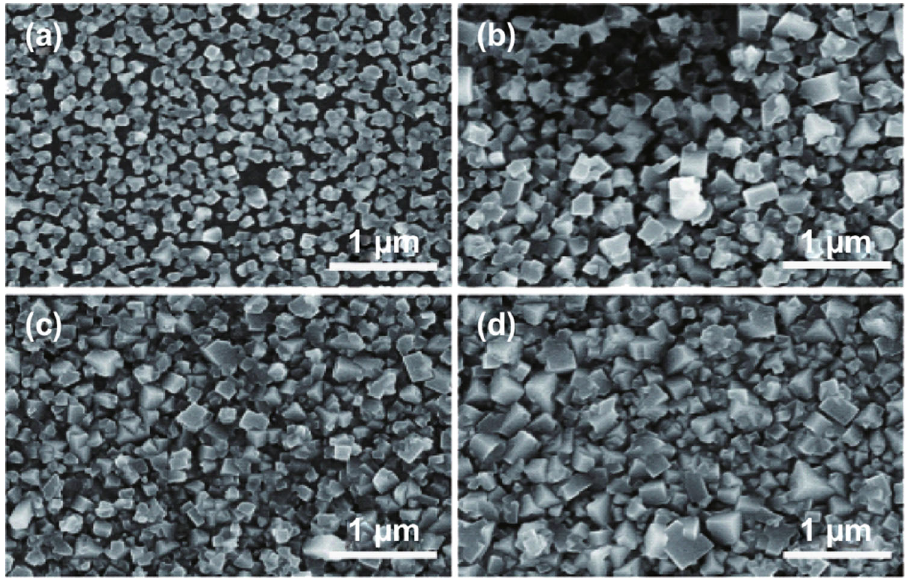
Fig. 21 SEM images of CH 3 NH 3 PbI 3 films of different PbI 2 concentrations: a 0.3 M, b 0.5 M, c 0.8 M, and d 1.1 M. Reproduced with permission Ref.